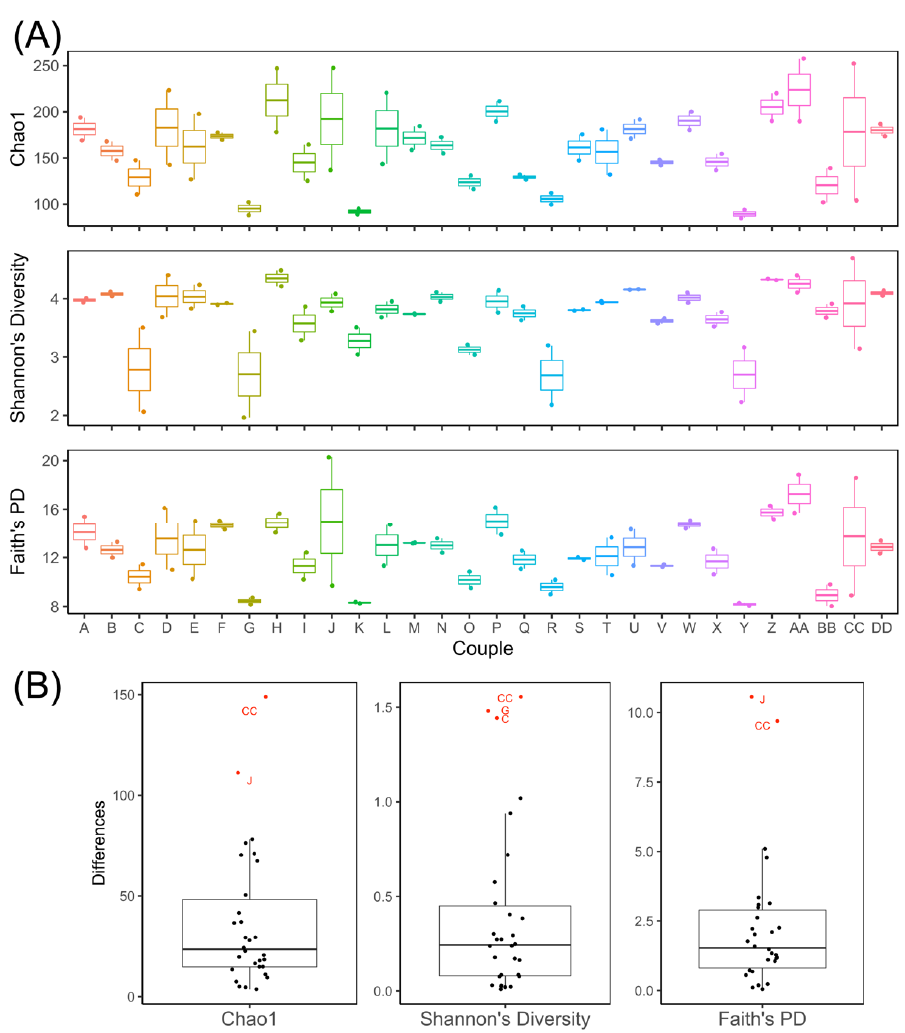
Figure 1. ( A ) Alpha diversity metrics. The labels on the x -axis represent anonymized couple identi- fiers. ( B ) Within-couple differences in alpha diversity metrics. Each point represents the absolute difference of the alpha diversity measures between individuals of one couple. Couples with differ- ences larger than the upper whisker of the boxplot (1.5 times the interquartile range above the hinge) are labeled and were treated as outliers. Faith’s PD: Faith’s phylogenetic diversity.